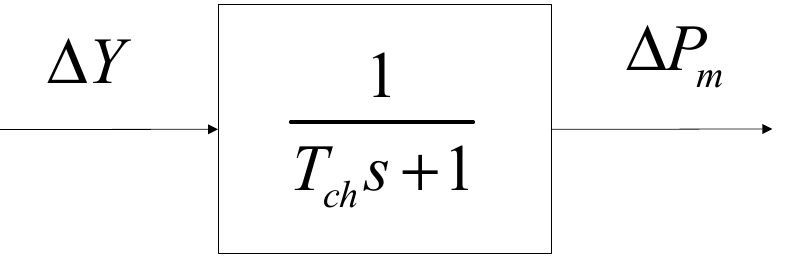
Figure 1. Model structure of the prime mover.